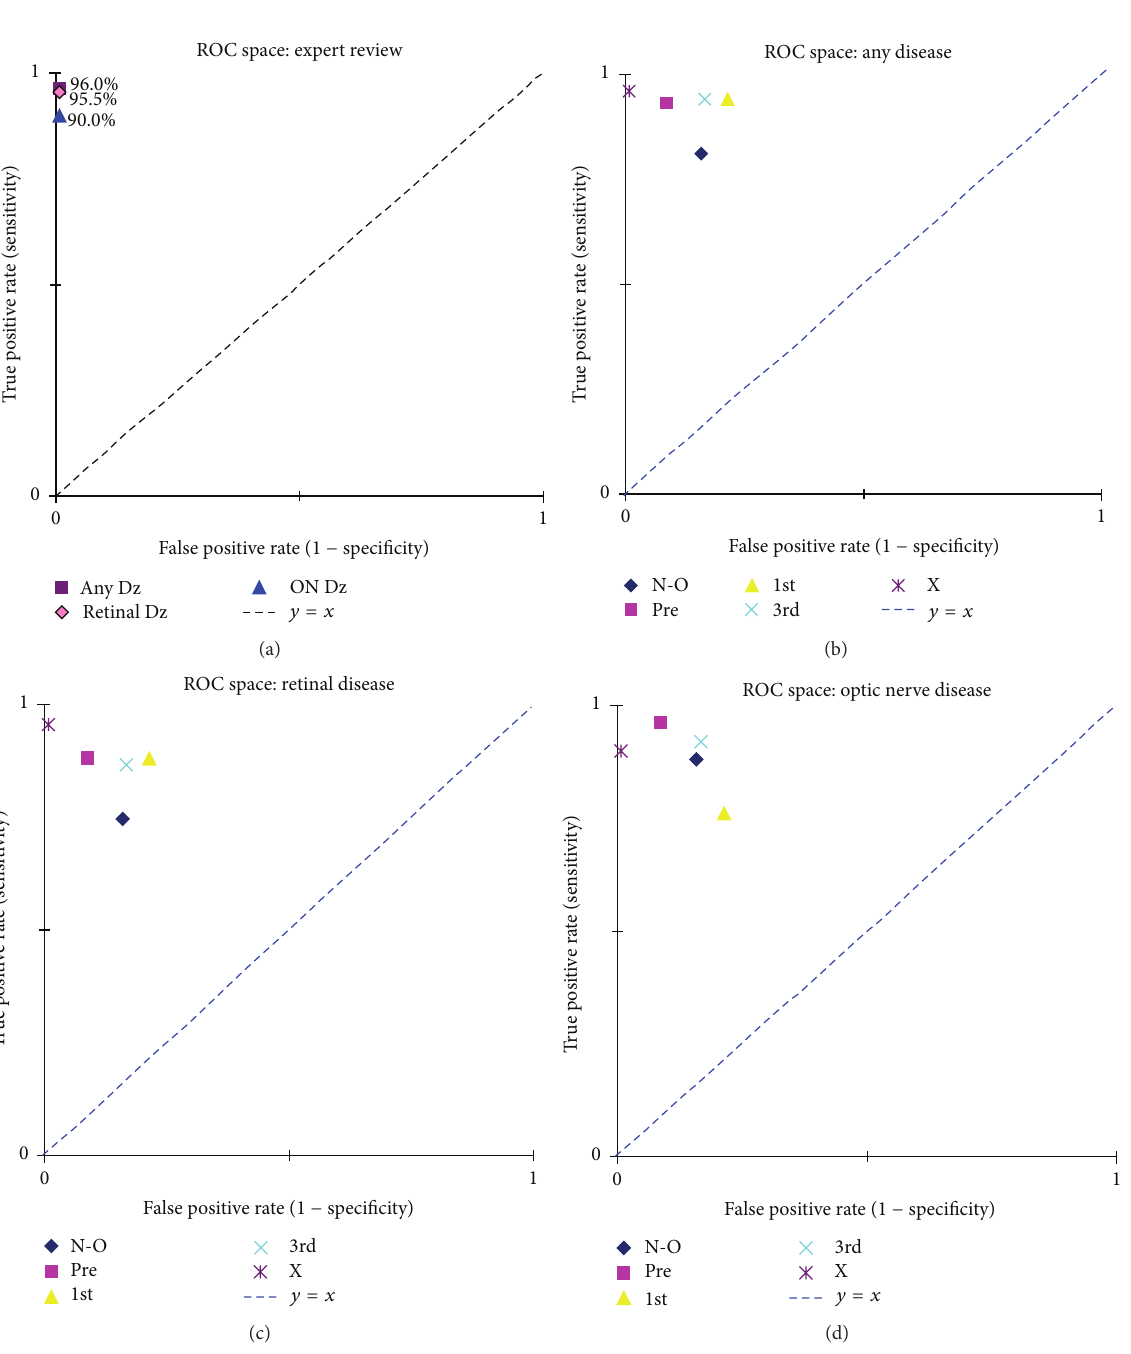
Figure 5: Receiver Operator Characteristics (ROC) space plots. (a) Expert performance for any disease, retinal disease, and optic nerve disease. (b–d) Comparison of all reviewers, including the expert, for (b) any disease, (c) retinal disease, and (d) ON disease. Key: N-O = nonoptometric technician; pre = pre-1st-year student/technician; 1st = 1st-year student; 3rd = 3rd-year student; X = expert. 𝑦 = 𝑥 : chance